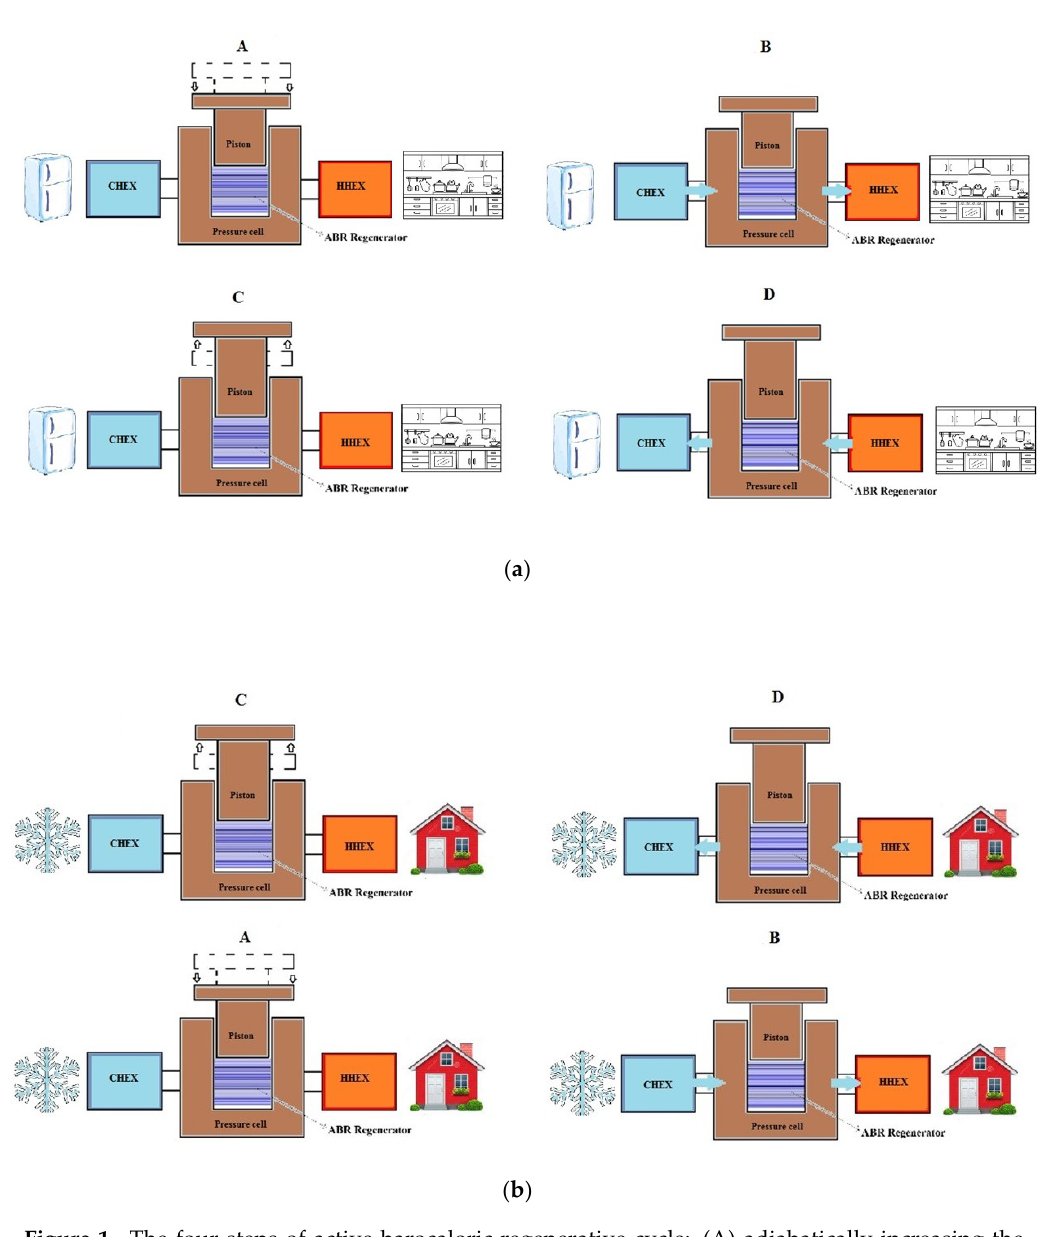
Figure 1. The four steps of active barocaloric regenerative cycle: (A) adiabatically increasing the hydrostatic pressure; (B) cold-to-hot flowing; (C) adiabatically decreasing the hydrostatic pressure; (D) hot-to-cold flowing for ( a ) cooling; ( b ) heat pumping operation modes.